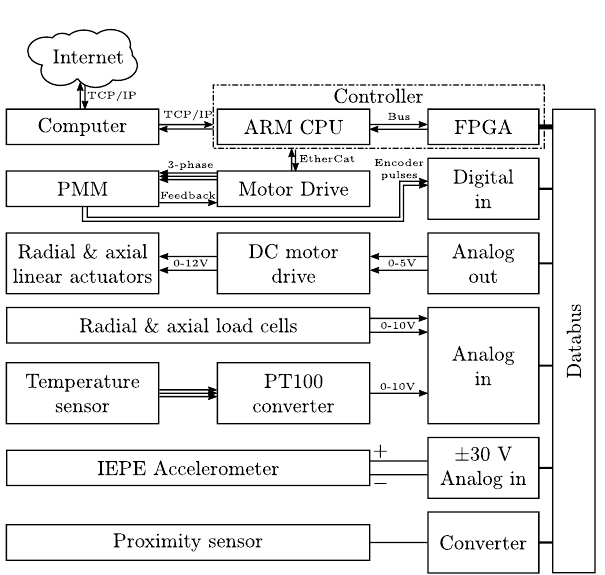
Figure 14: Electronic hardware